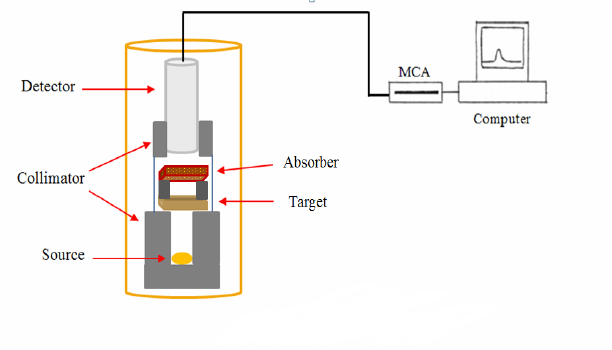
Fig.1: Schematic diagram of experimental